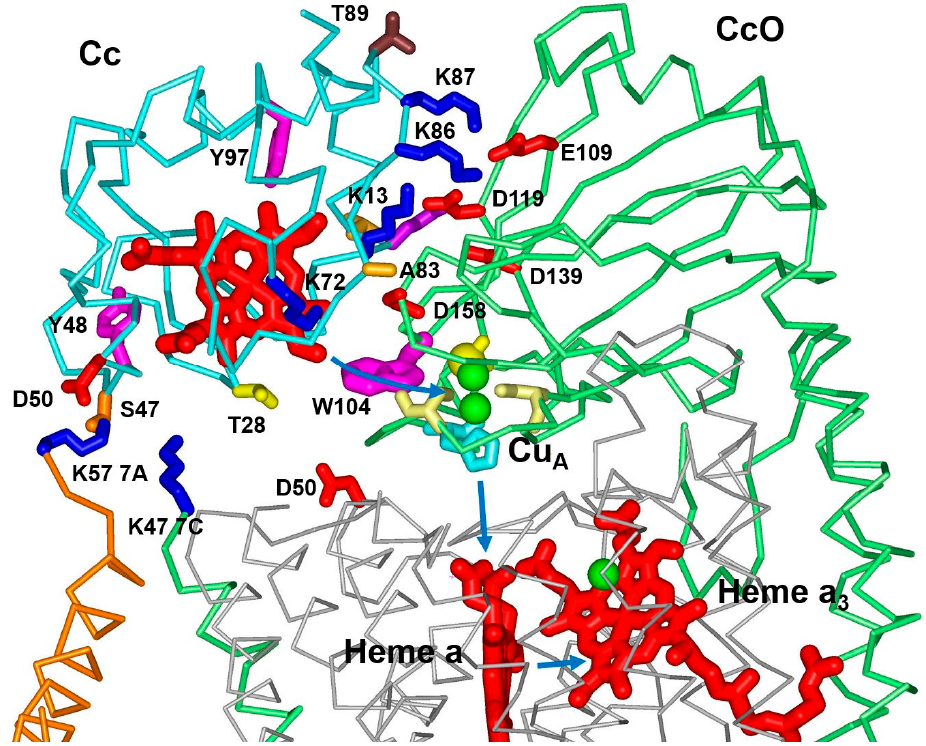
Figure 2. Computational model of the Cc:CcO complex based on the crystal structures of Cc (PDB 1HRC) and CcO (PDB 1OCC) [52]. Cc is colored blue, CcO subunit II is green, subunit I is grey. subunit 7A is orange, and subunit 7C is green. The positively charged Cc lysine residues are colored blue, and the negatively charged CcO glutamate and aspartate residues are colored red. The Cc amino acids mutated in this study are also shown. Blue arrows show the electron transfer pathway.